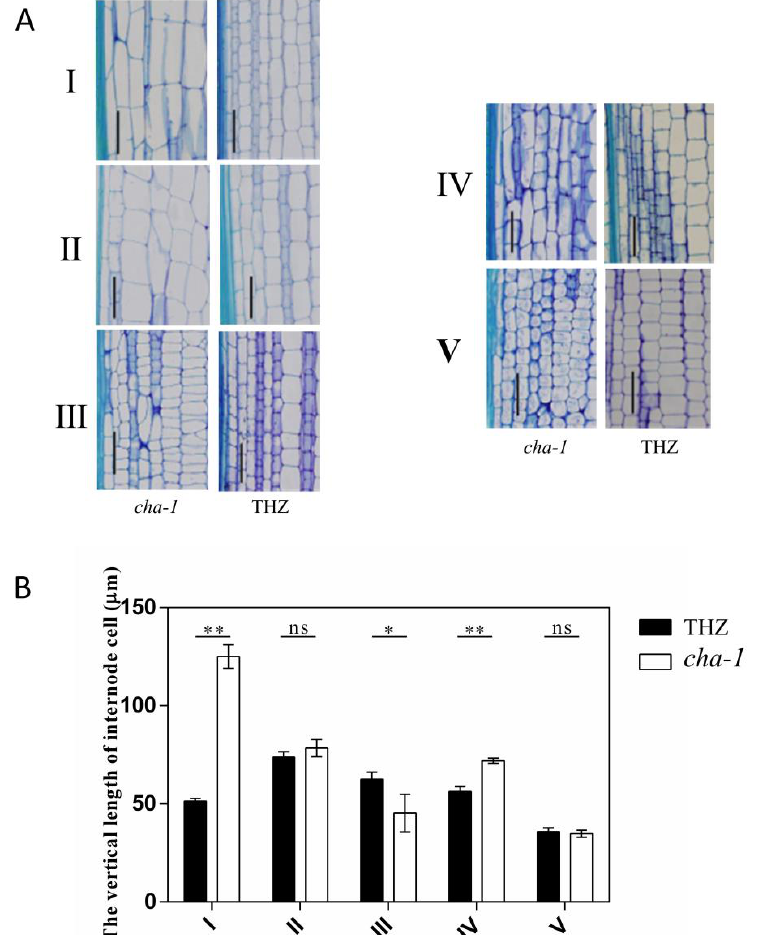
Figure 2. Histological comparison of internodes between THZ and CHA-1. ( A ) Longitudinal sections of five internodes of THZ and CHA-1 . Scale bar, 100 µ m. ( B ) Comparison of the vertical length of internode cells between THZ and CHA-1 . Values are means ± SD. I, II, III, IV, and V represent internode I, internode II, internode III, internode IV, and internode V, respectively. *, p < 0.05; **, p < 0.01; ns, no significance (Student’s t- test).